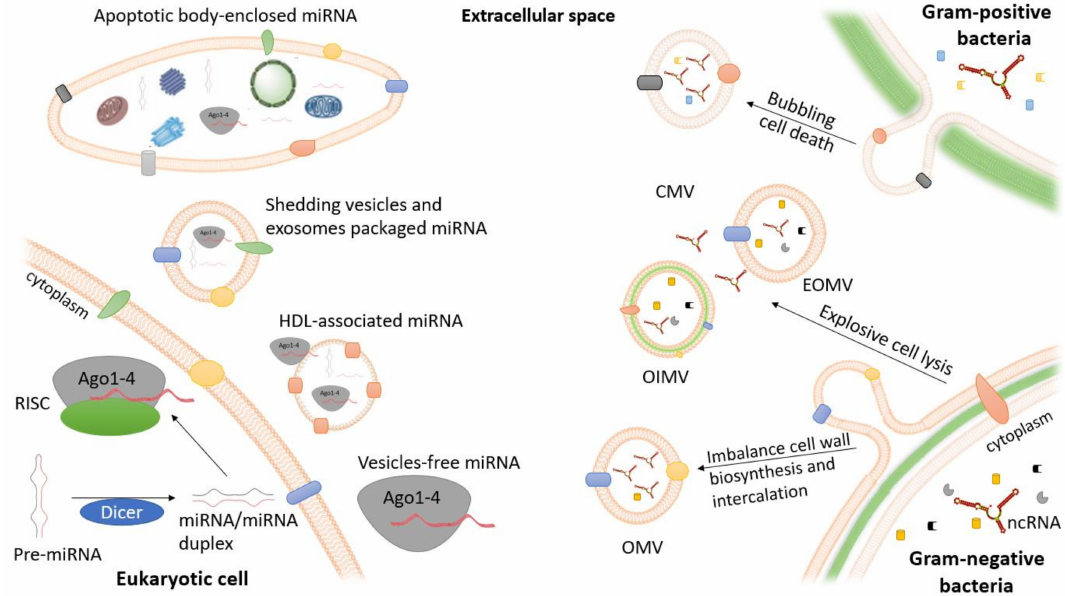
Figure 1. Modes of extracellular miRNA packaging in eukaryotic cells and routes leading to the formation of di ff erent membrane vesicle types in bacteria. Extracellular miRNAs can be cargo in membranous vesicles or can be vesicle free and associated with either Argonaute (Ago) proteins alone or incorporated into HDL particles. Apoptotic bodies, shedding vesicles, and exosomes are three types of membranous vesicles that contain these extracellular miRNAs. Apoptotic bodies can also contain various cellular organelles including mitochondria and nucleic acids [28]. In bacteria, distinct membrane vesicles are formed by Gram-negative and Gram-positive bacteria. Blebbing of the outer membrane and explosive cell lysis are the two main routes for vesicle formation in Gram-negative bacteria. The membrane vesicles from these bacteria can be divided into outer-inner membrane vesicles (OIMVs), explosive outer membrane vesicles (EOMVs), and traditional OMVs according to their formation routes, structures, and compositions [45]. In Gram-positive bacteria, membrane vesicles are formed by a mechanism involving the prophage-encoded endolysin that generates holes in the peptidoglycan cell wall, allowing the cytoplasmic membrane material to protrude into the extracellular space and release the cytoplasmic membrane vesicles (CMVs). CMVs can contain membrane and cytoplasmic components